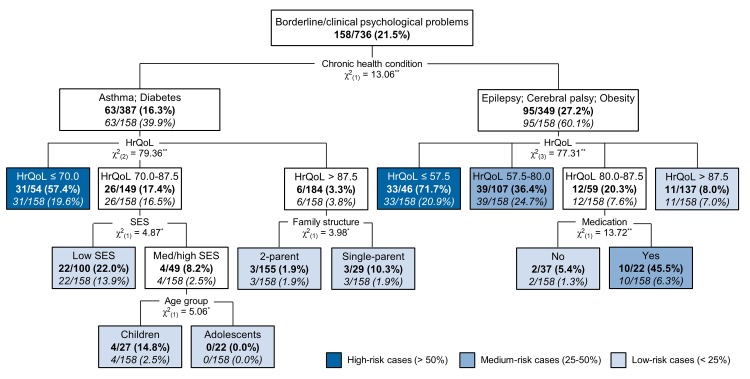
Decision-tree model predicting borderline/clinically significant psychological problems.Note. The colored terminal nodes show the rates of having borderline/clinical psychological symptoms within each profile (bold) and within the total target group (italic); The terminal nodes are colored coded into high-risk cases (> 50%); medium-risk cases (25–50%); and low-risk cases (< 25%); *
p ≤ .05; **
p ≤ .01, two-tailed.